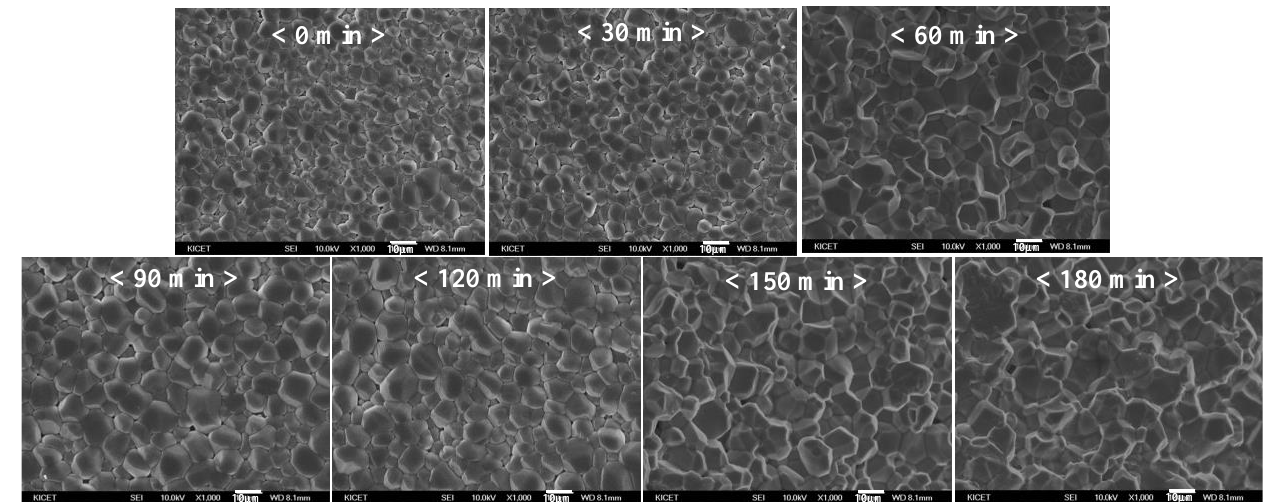
Figure 7. SEM images of 3YSZ 3D-printed sintered body according to sintering time. The percentage of shrinkage of the 3YSZ sintered body was observed at different sintering times at 1450 °C, as shown in Figure 8a. As the sintering time increased, the volume shrinkage increased from 40% to 51%, and was mainly influenced by the percentage shrinkage in thickness, in the same manner as the effect of the sintering temperature. The relative density and grain size of the 3YSZ 3D-printed sintered body were analyzed according to the sintering time, as shown in Figure 8b. While the grain sizes of the sintered bodies with sintering times of 0 and 30 min were similar, the grain size also increased as the sintering time increased above 60 min. This is consistent with the XRD results showing that tetragonal peak separation became clearer in the sintered body when the sintering time was greater than 60 min. The relative density according to the sintering time gradually increased as the sintering time increased, but the maximum relative density of 99.95% was observed when sintering for approximately 150 min, which